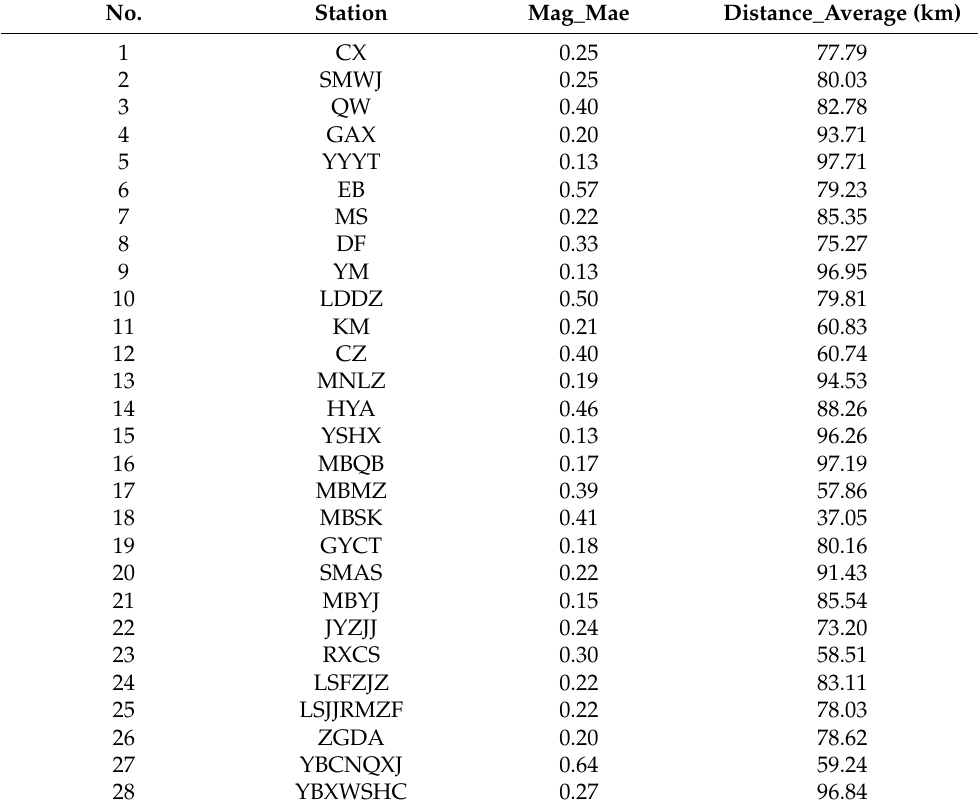
Table A6. Prediction results of LSTM model for magnitude and epicenter on area2.